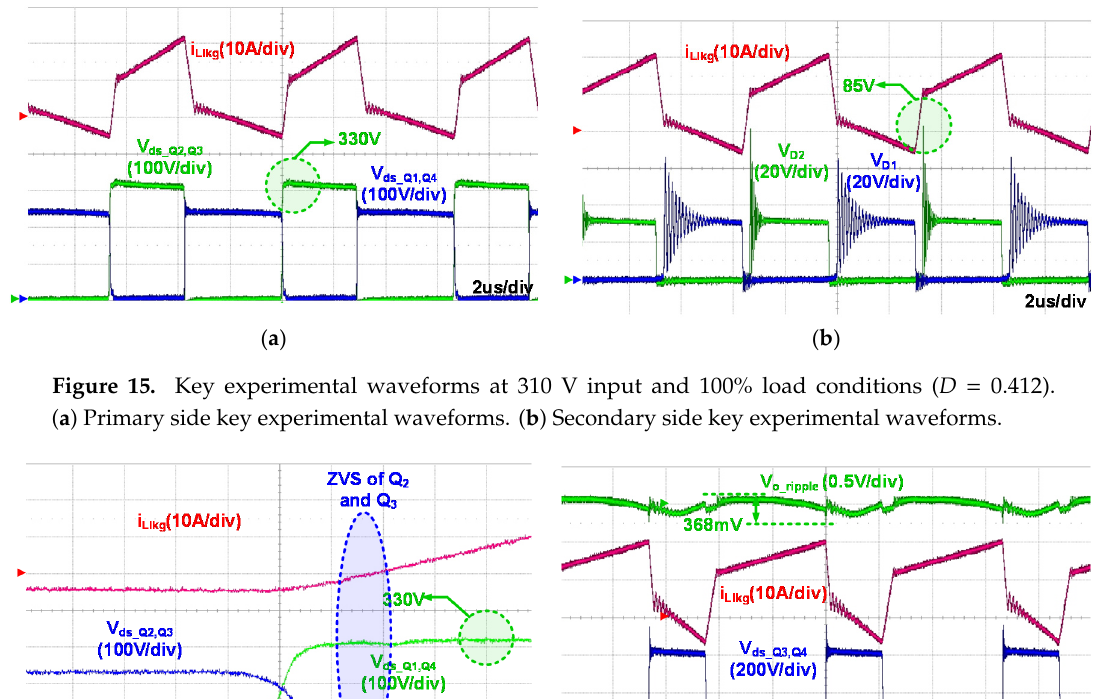
Figure 14. Key experimental waveforms at 200 V input and 100% load conditions ( D = 0.464). ( a ) Primary side key experimental waveforms. ( b ) Secondary side key experimental waveforms.